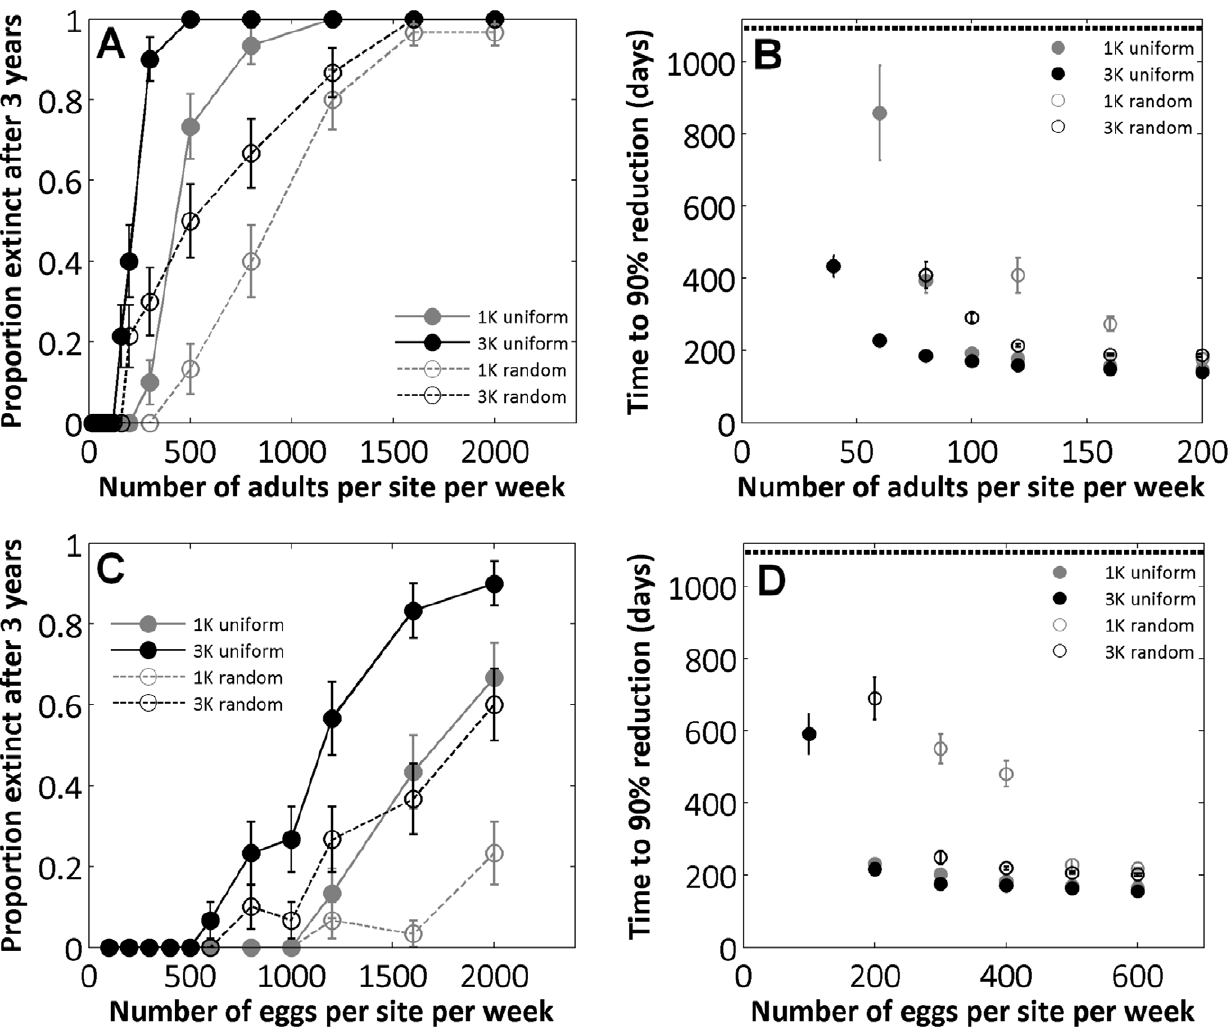
Figure 2. Releases in 10% of houses. Proportion of simulations that reached extinction after 3 simulated years (left panels A and C) and time to reach 90% population reduction (right panels B and D) for point source release strategies, when male adults (upper panels A–B) or eggs (bottom panels C–D) are released weekly. For each scenario 30 replicated simulations were run. Solid lines and filled markers: uniform distribution of release sites; dashed lines and open markers: random distribution of release sites. Gray lines: 1 lethal element; black lines: 3 lethal elements. A–C: Error bars give the estimated standard error as in Fig. 1. B–D: error bars give standard deviation. Note that in panels B and D, individual simulations that do not reach at least a 90% reduction in 3 years (horizontal line) were excluded from calculations of the average and